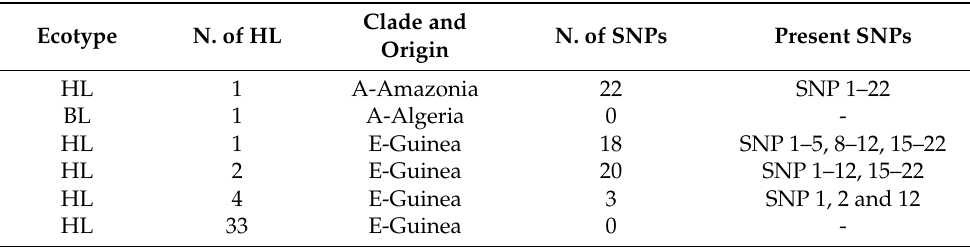
Table 2. PHUM540560 gene SNPs profile of Guinean clade E-head lice, Amazonian and